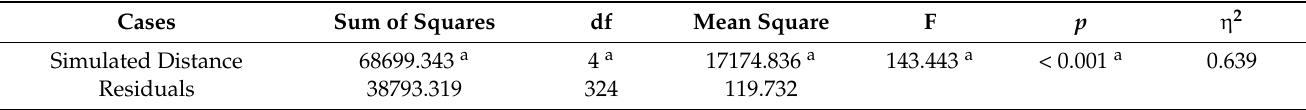
Table A2. Exp 1—repeated-measures ANOVA—comparing target positions.